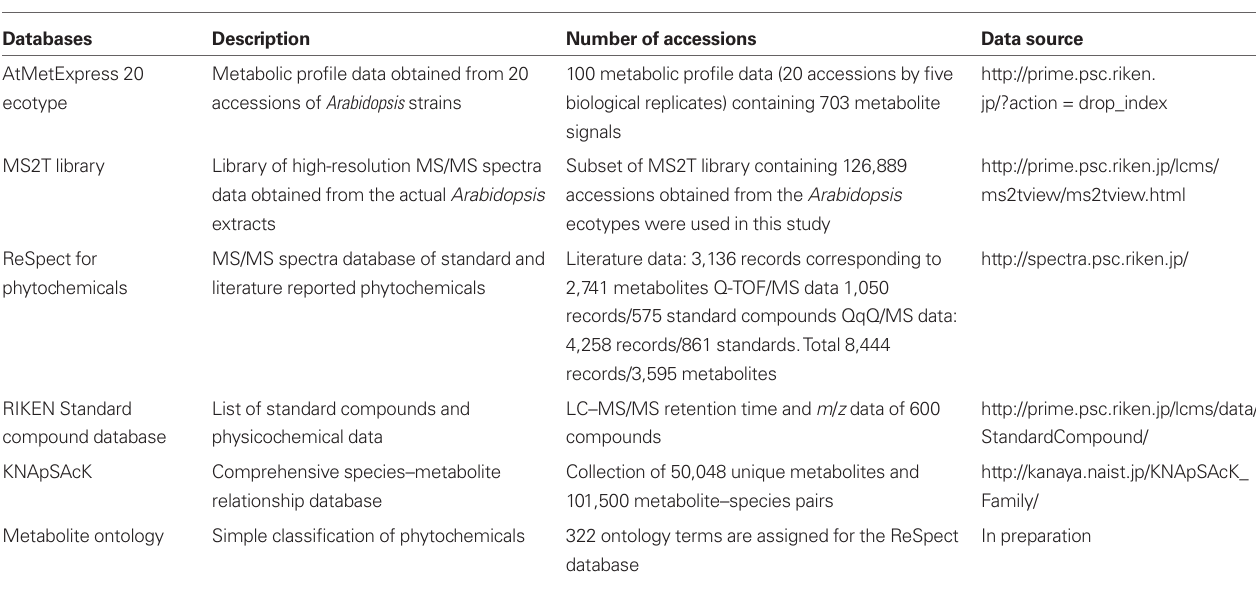
Table 1 | List of databases and datasets used in this